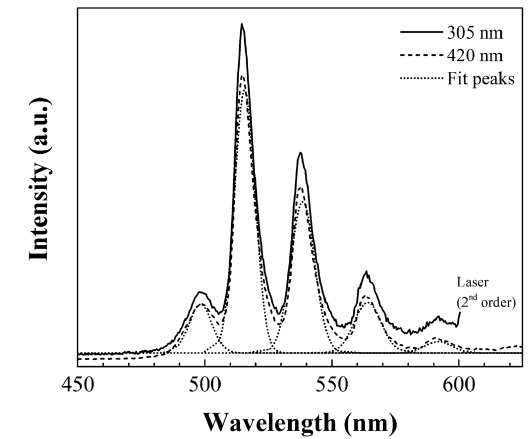
Fig. 4. ATR-FTIR spectrum of [UO